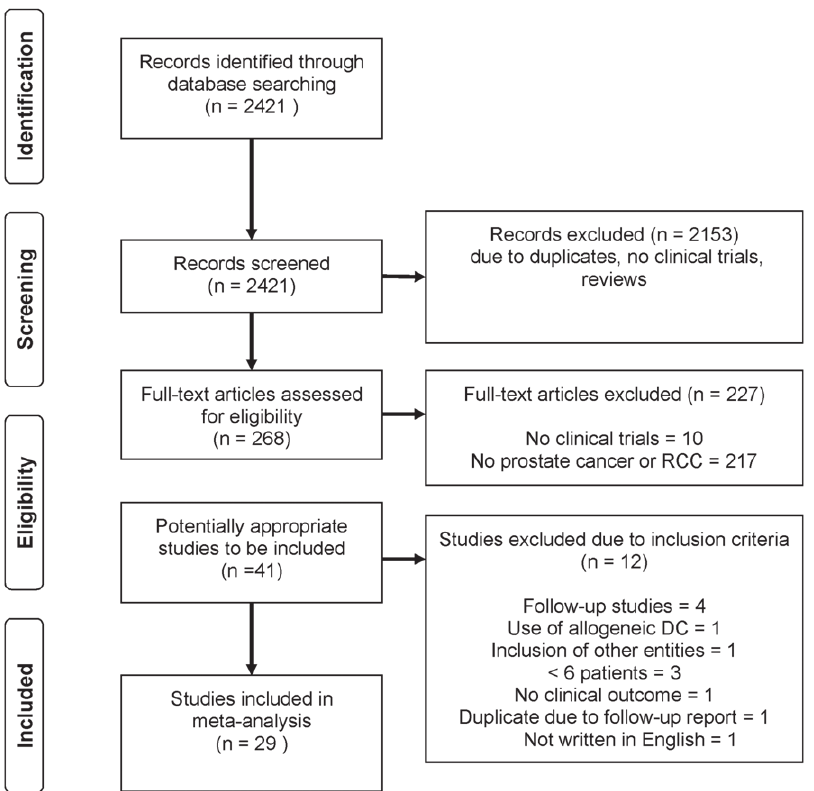
Figure 1. Flow diagram showing record identification, record screening, full text article eligibility and study inclusion process.